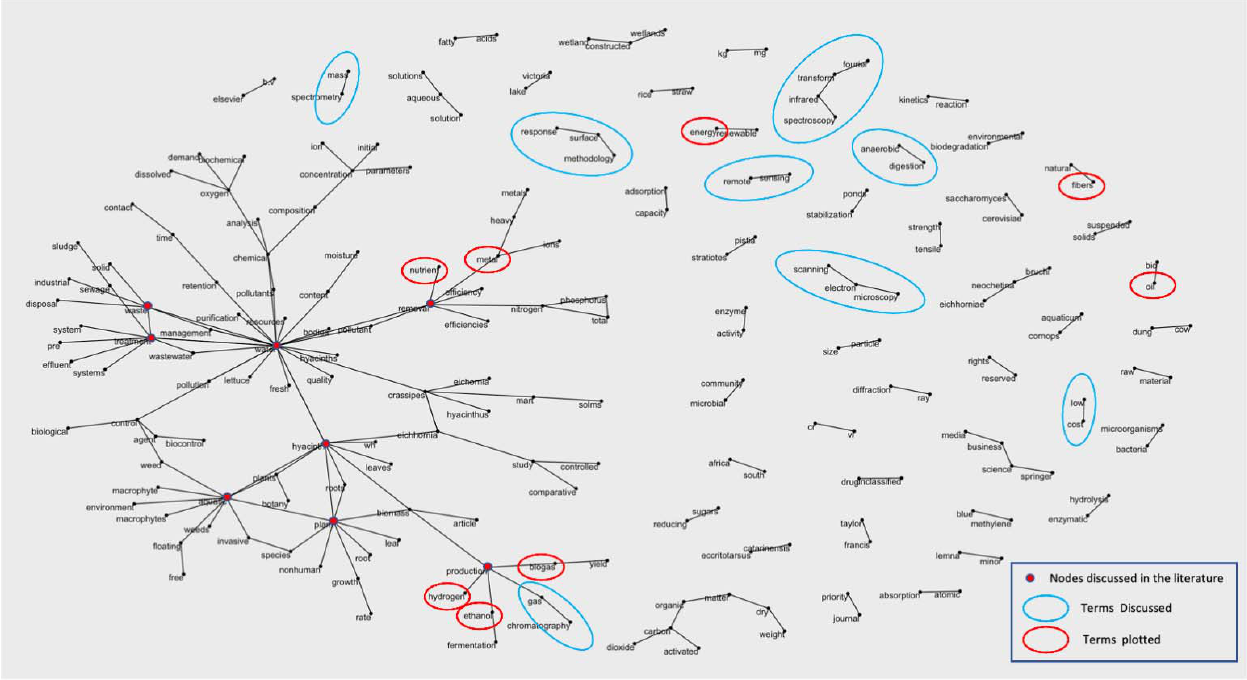
Figure 7. Network plot of water hyacinth literature.